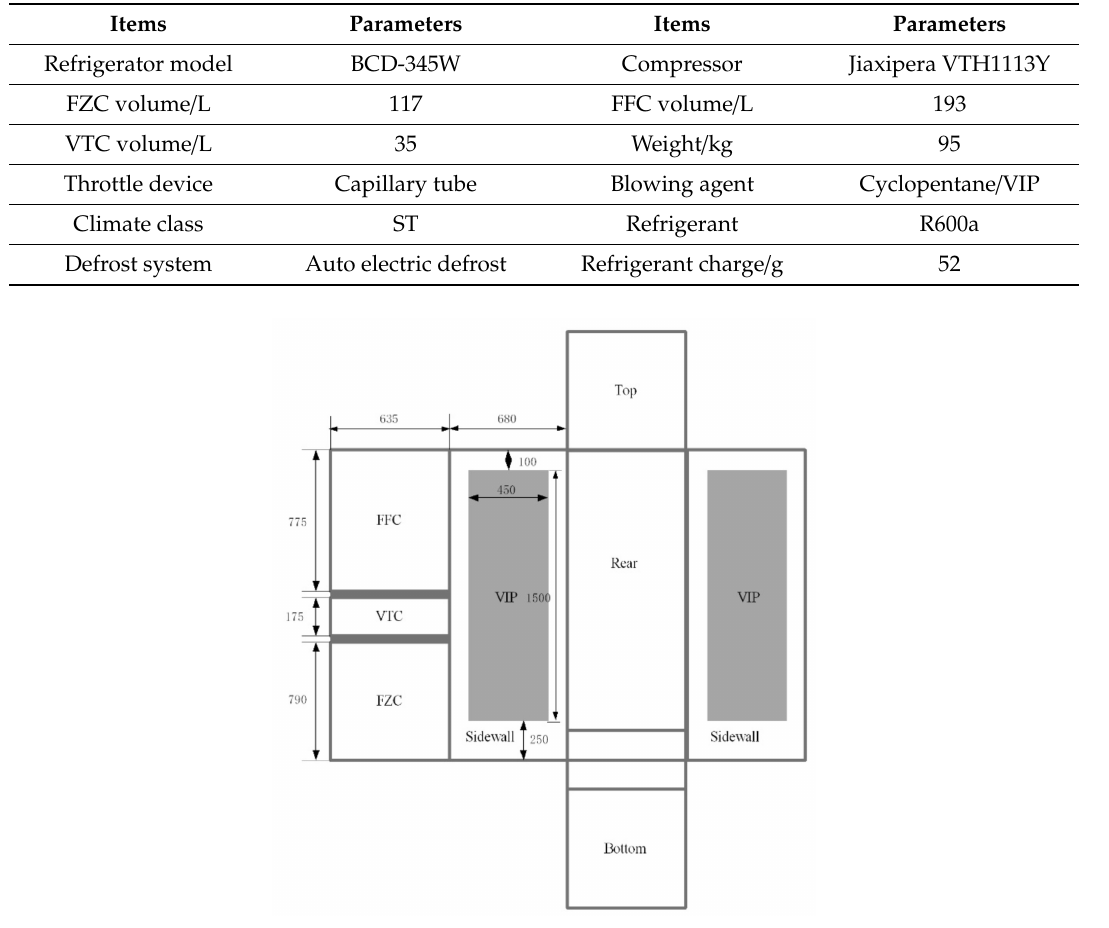
Figure 2. Layout of VIPs embedded into two sidewalls of the refrigerator. (VIP means vacuum insulation panel as defined in the